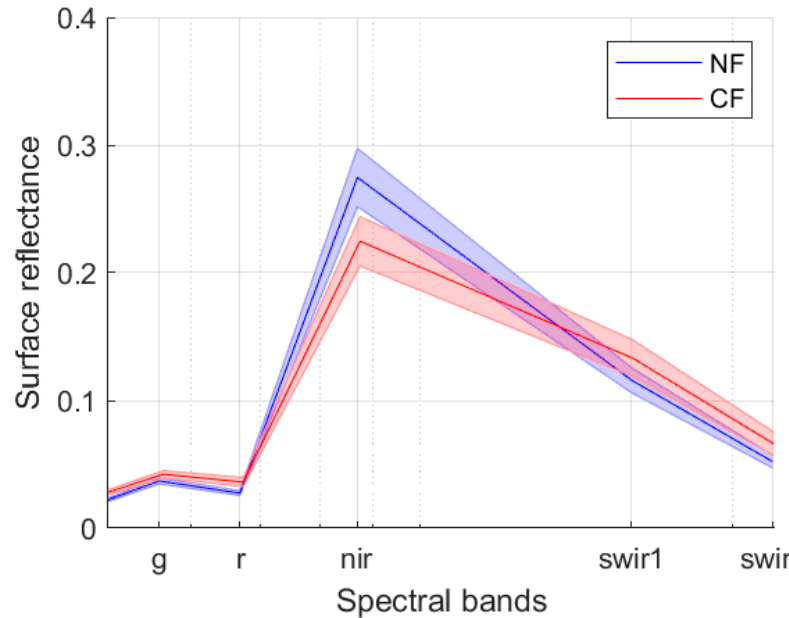
Figure 5. Spectral reflectance from Landsat-8 Operational Land Imager (OLI) acquired on 30 January 2019. The thick lines are the means of surface reflectance from the pixels where canopy photos were taken, and the shaded areas are one standard deviation from the means.